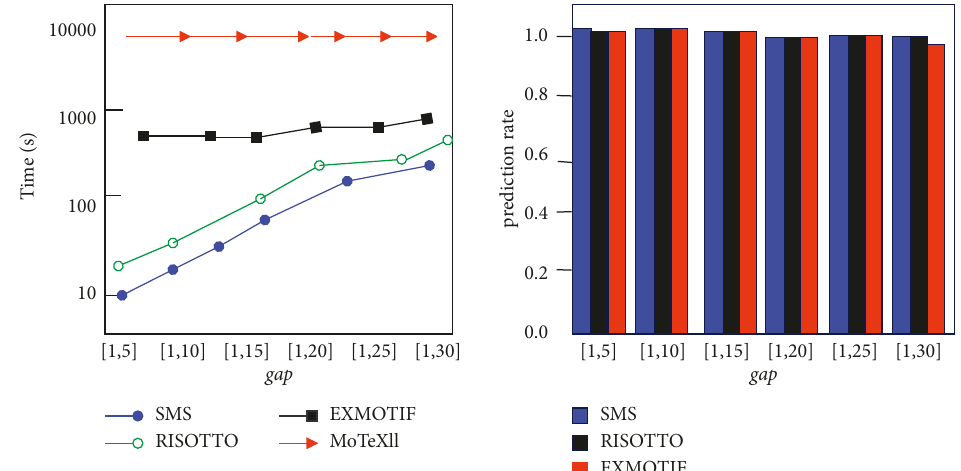
Figure 7: Experimental results on different gaps.